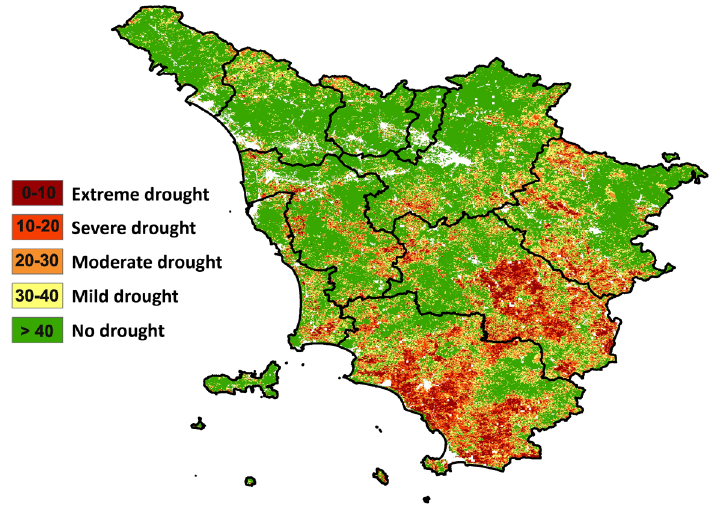
Figure 5. VHI (Vegetation Health Index) related to the 16–31 October 2017